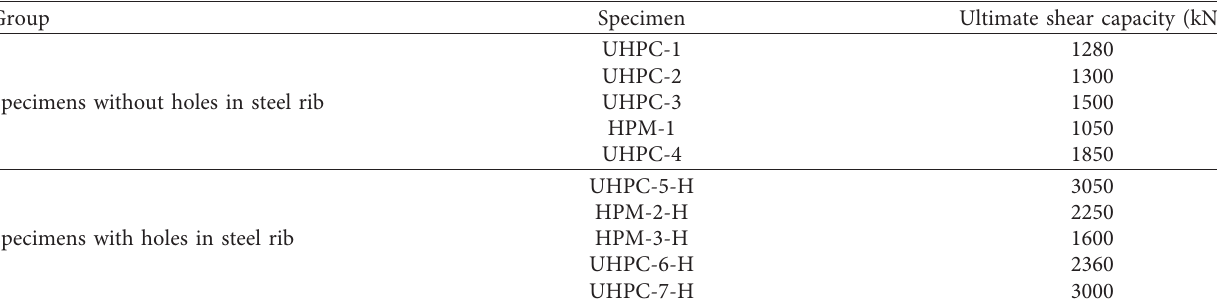
Table 3: Ultimate shear capacity of push-out test specimens.